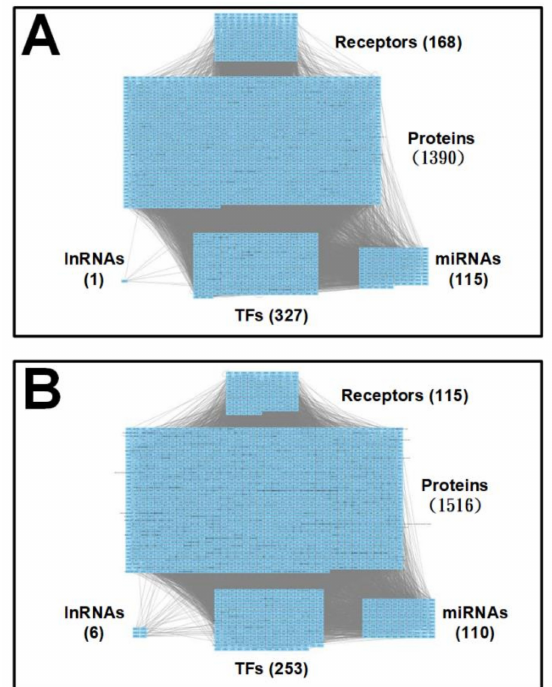
Figure 2. The identified genome-wide core GEN for ( A ) early-stage AD and ( B ) later stage AD. The core GENs are extracted from the real GENs (Figure S1) by the proposed principal network projection (PNP) method. The grey lines represent the interactions between groups, including receptors, proteins, miRNAs, TFs, and